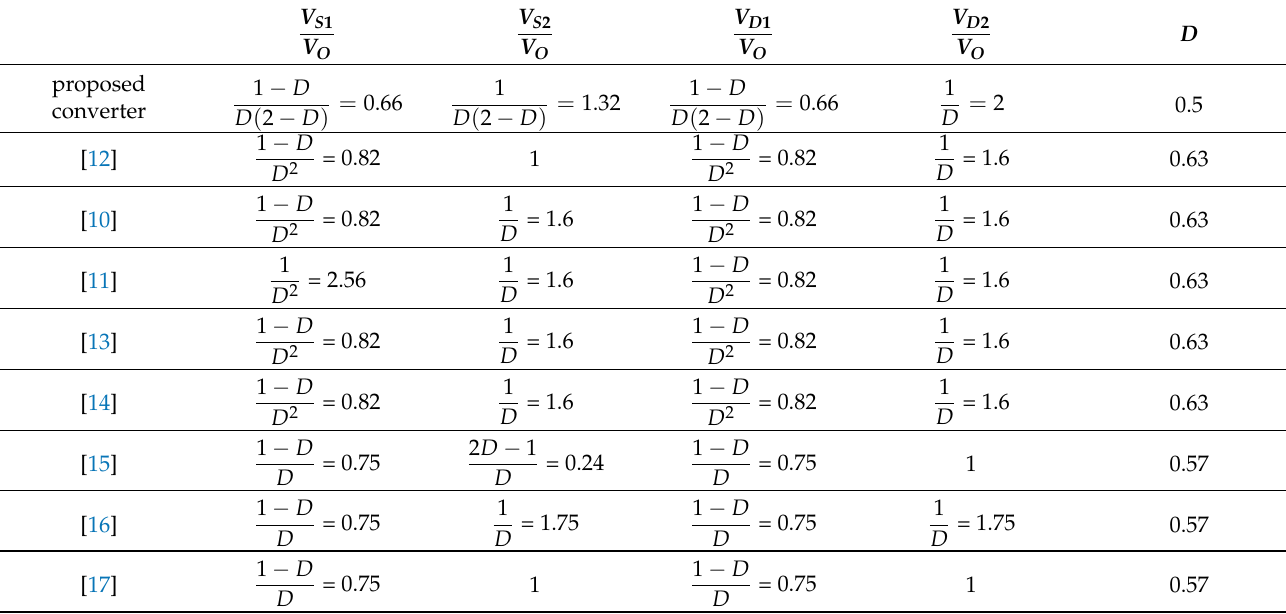
Table 3. Comparison of the normalized voltage stress of semiconductors as the voltage gain ratio equals